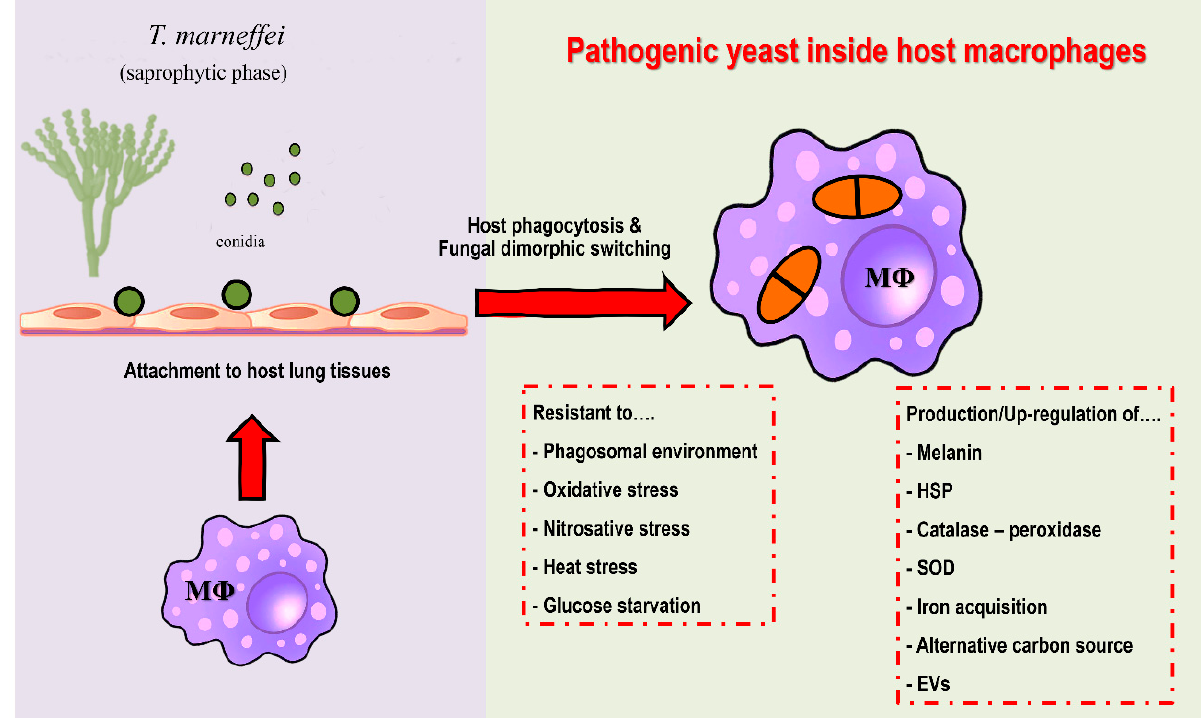
Figure 2. Potential virulence factors of T . marneffei . After attachment to host lung tissue via a host extracellular matrix, host macrophages are the first line of defense against T . marneffei . Conidia are phagocytized by alveolar macrophages . After internalization, T. marneffei rapidly undergo morpho- genic transition to the pathogenic yeast cells and multiply intracellularly . T. marneffei then combat various stressors from macrophages, e . g . , acidic phagolysosome, reactive oxygen species, reactive nitrogen species, heat stress and glucose deficiency . The fungus is forced to adapt and compensate through virulence factors due to host macrophage pressure, as detailed in the figure . Overall, the traits required for survival and growth in host macrophage environment are considered as potential virulence factors . ( Abbreviations : M Φ ; macrophages, HSP; heat shock protein, SOD;